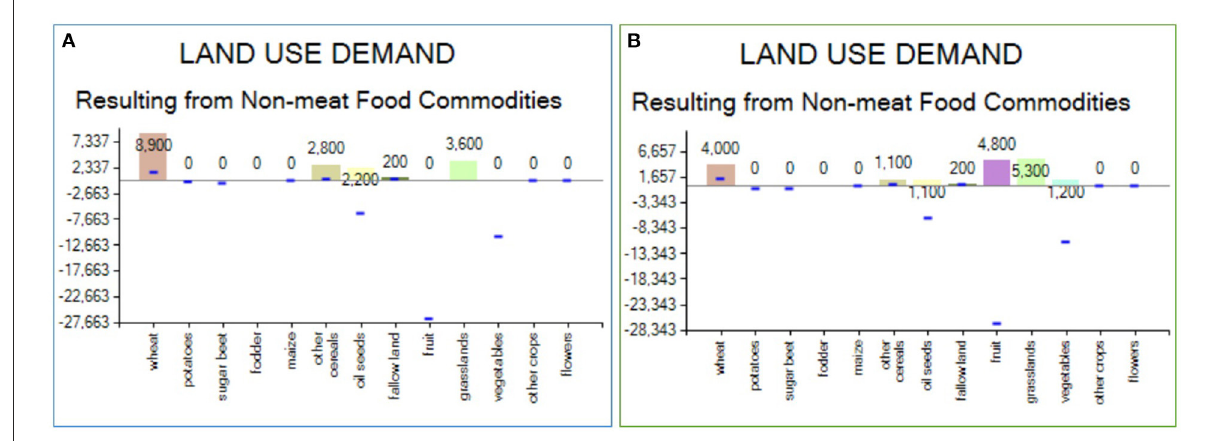
FIGURE11 Assessment of scenario proposed by Group 1. (A) Reference, (B) Group 1’s scenario. Charts show the supply-demand values for each food group within a particular ring. Bar charts show total supply hectares for each food group. Blue lines on bars portray the supply-demand difference, i.e., how much the supply is meeting the demand. Demand is met when the blue line is at ZERO point.